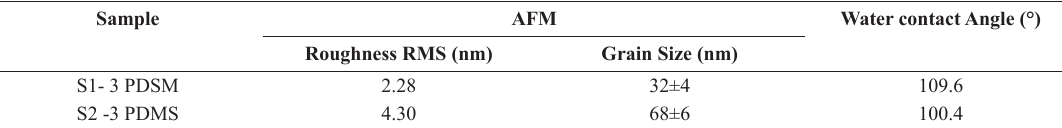
Table 2. Surface properties of PS end-capped 3-short-arm